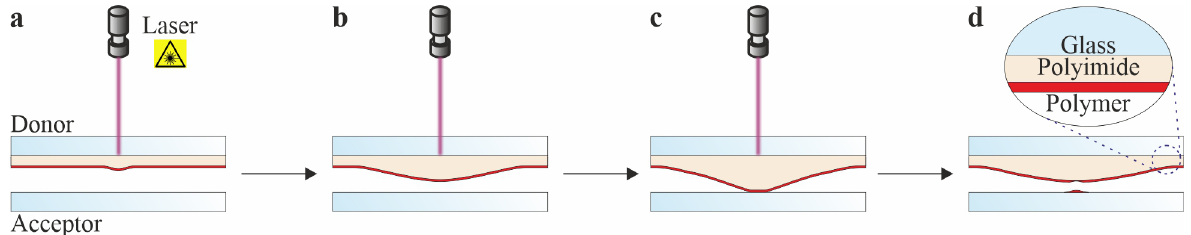
Figure 1. The four steps of the cLIFT material deposition: initial laser irradiation and minor deforma- tion of the polyimide layer ( a ). Bell-shaped expansion of the polyimide layer during continuing laser irradiation ( b ). Stable contact through the expanded polyimide layer ( c ). Relaxation of the polyimide layer and material deposition of the donor substrate ( d